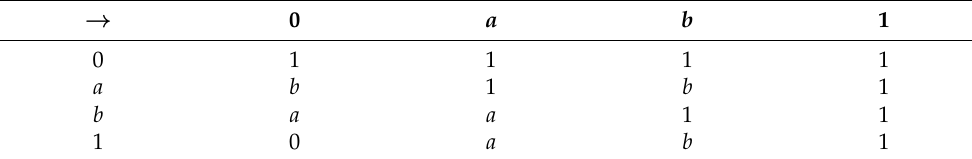
Table 14. The operation →